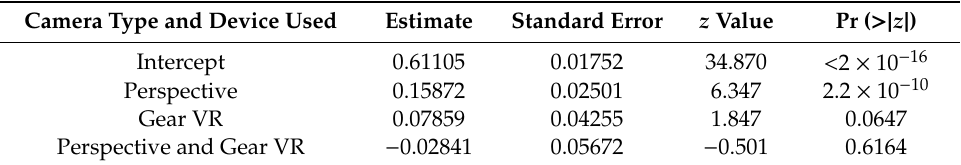
Table 17. Logistic regression analysis results of the additive model of camera type and device used, allowing interactions.